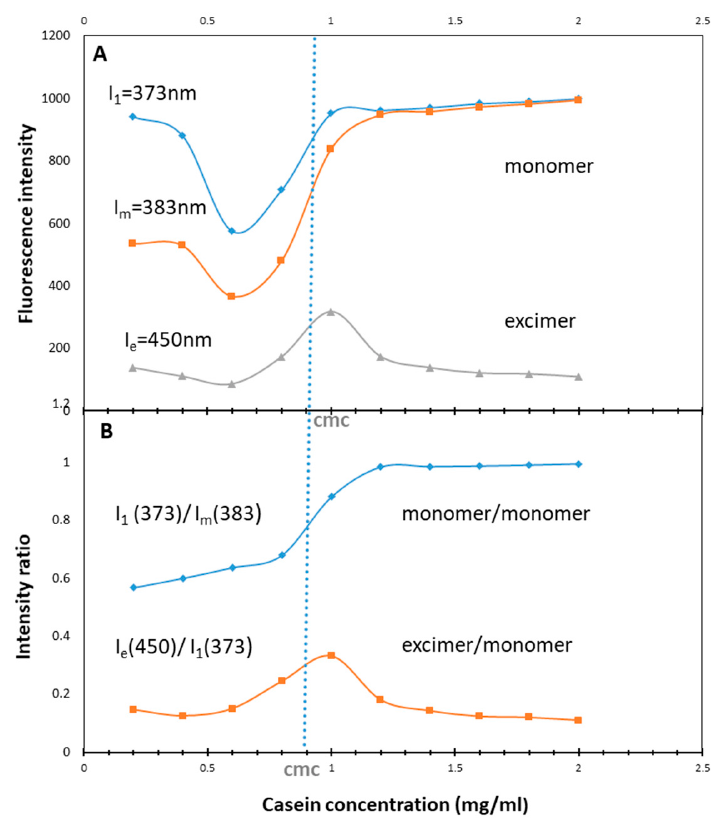
Figure 6. Fluorescence emission of pyrene in aqueous solutions of di ff erent concentrations of the casein, ranging from 0.2–2.0 mg / mL ( A ) Fluorescence intensity in the monomer band, at peak I (373 nm, circles) and peak III (383 nm, squares) and in the excimer band at 450 nm, (triangles) as function of the casein concentration. ( B ) Intensity ratios: I 1 / I m (circles) and I e / I 1 (triangles). The dashed blue vertical line designates the cmc of the caseinate micelles.